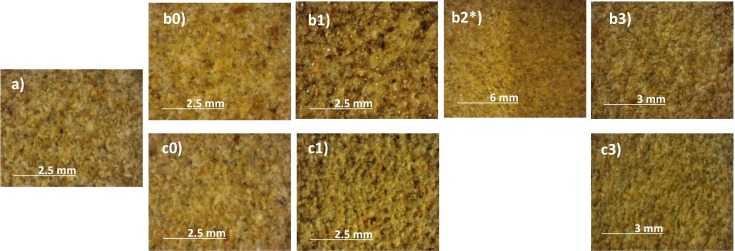
Stereographic microscopy images of the surface of sandstone.Untreated (a) and coated with AG1(b) and AG2(c): unweathered (0), after 12 months of outdoor exposure (1) and after 1500 (2) and 2000 hours (3) in a QUV chamber * Just the right half of the sample has been exposed to UVB radiation.